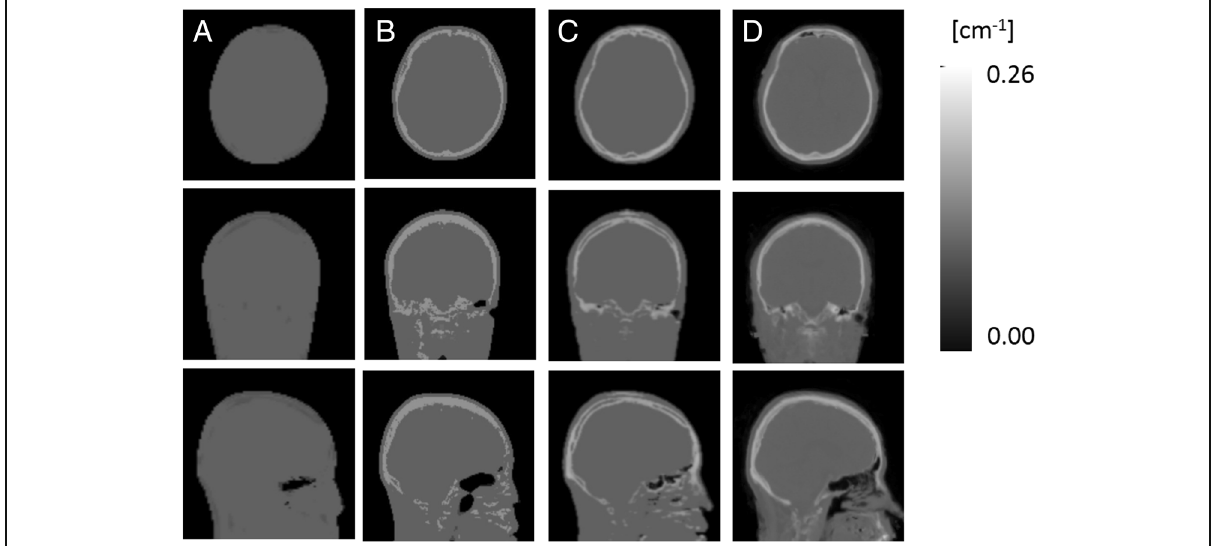
Fig. 1 Axial (top), coronal (middle), and sagittal (bottom) views of an exemplar μ -map DXN ( A ), μ -map dUTE ( B ), μ -map dUTE − R2 ( C ), and pCT ( D